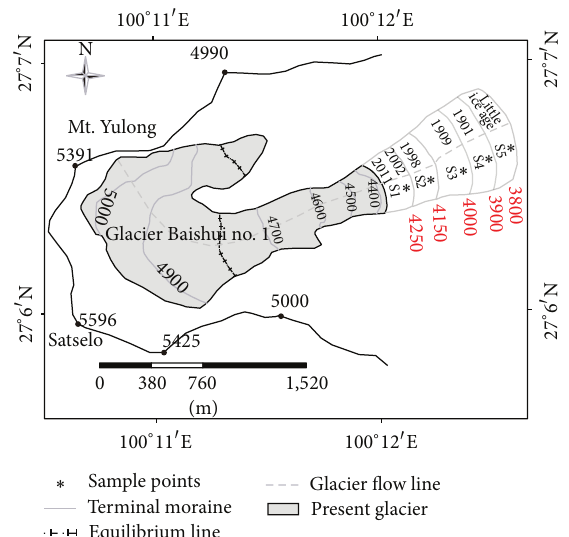
Figure 1: Map of sampling points at the Glacier-BS1 foreland on Mt. Yulong. ∗ S1–S5, represent five widely spaced sampling sites. Each site was sampled with ten quadrats. Solid blue lines represent the terminus of the glacier in 2002, 1998, 1909, 1901, and the 17–19th